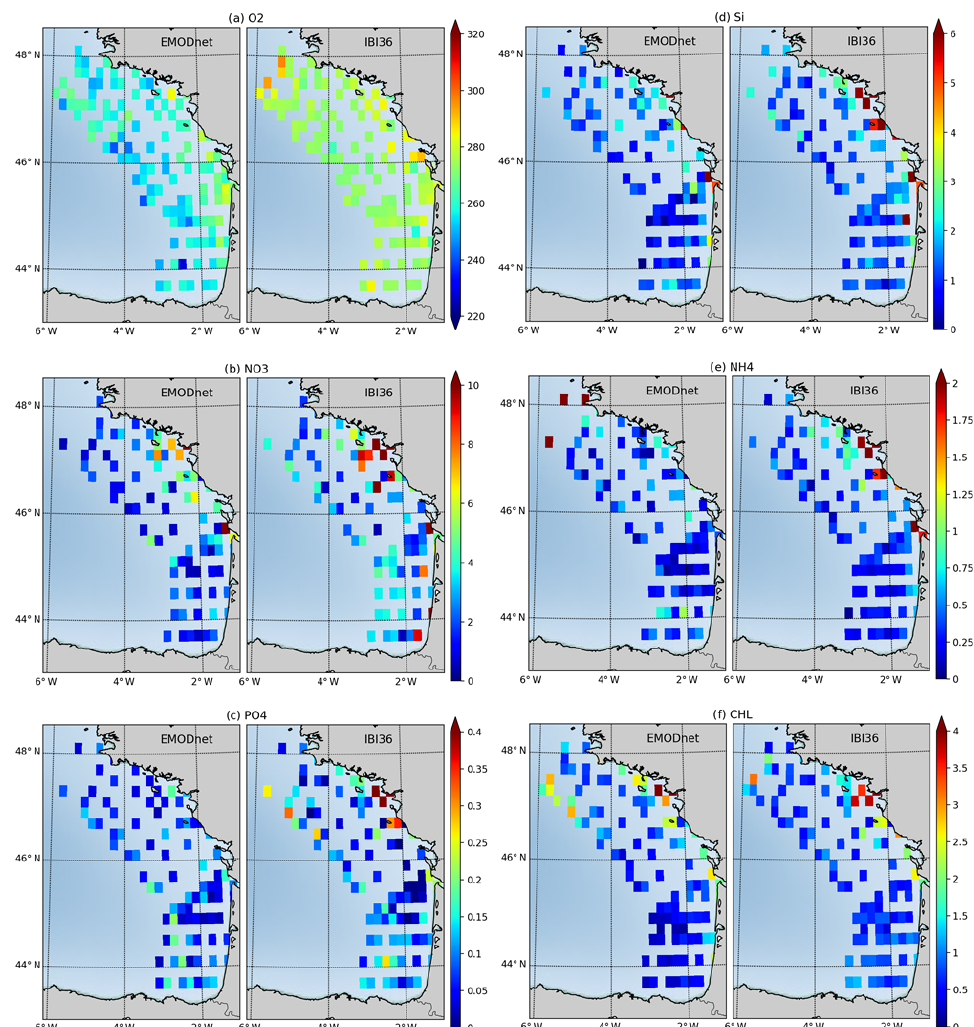
Figure 13. Surface concentrations of oxygen (a) , nitrate (b) , phosphate (c) , silicate (d) , ammonium (e) and Chl a (f) from the PELGAS data of the EMODnet database (left of each panel) and IBI36 (right of each panel). Oxygen and nutrients are expressed in µmolL − 1 and Chl a in mgChlm − 3 . IBI36 and PELGAS data are collocated in space and time between 2010 and 2016. Match-ups are averaged between 0 and 10m depth, gridded and averaged on a horizontal grid of 0 . 2 ◦ × 0 . 2 ◦